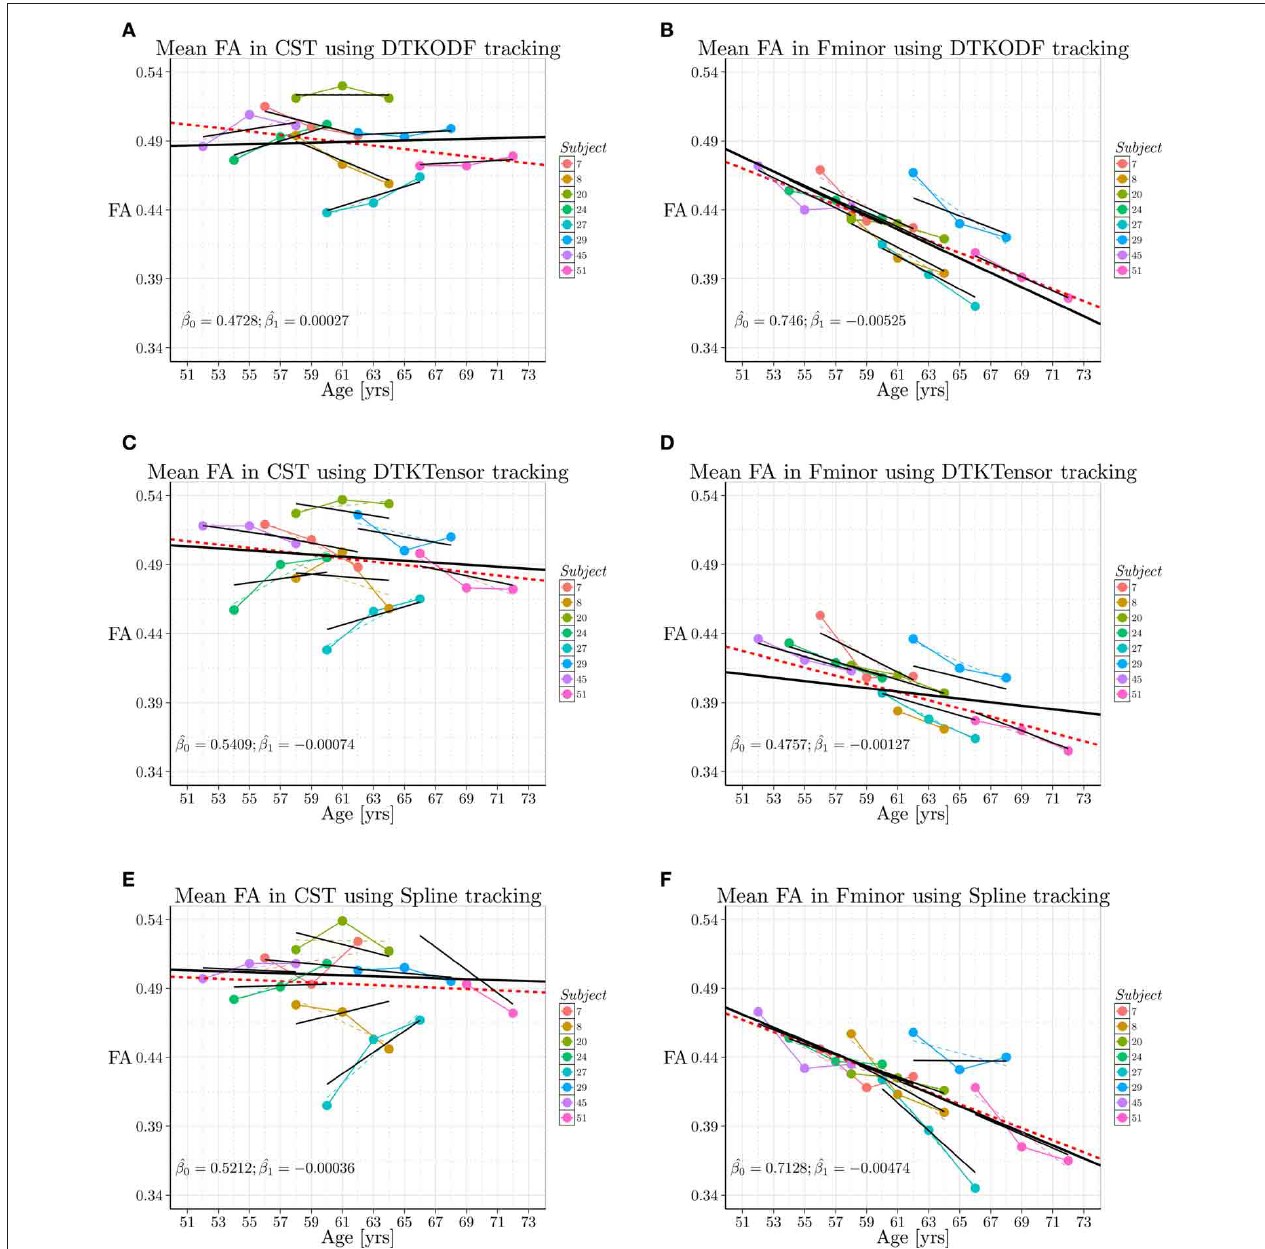
FIGURE 4 | Spaghetti plots from longitudinal analysis (wave1 ∼ 2005, wave2 ∼ 2008/9, wave3 ∼ 2011/12) of tract grand mean FA ( y -axis) for each of the eight subjects selected from the cohort. Age of subject ( x -axis) is given in years. Left column: Corticospinal tract . Right column: Forceps minor . Upper row: DTKODF tracking. Middle row: DTKTensor tracking. Lower row: Spline tracking. In each panel (A–F) the fixed effects estimates ( ˆ β 0 and ˆ β 1 ) are given. The colored, thin broken lines are the